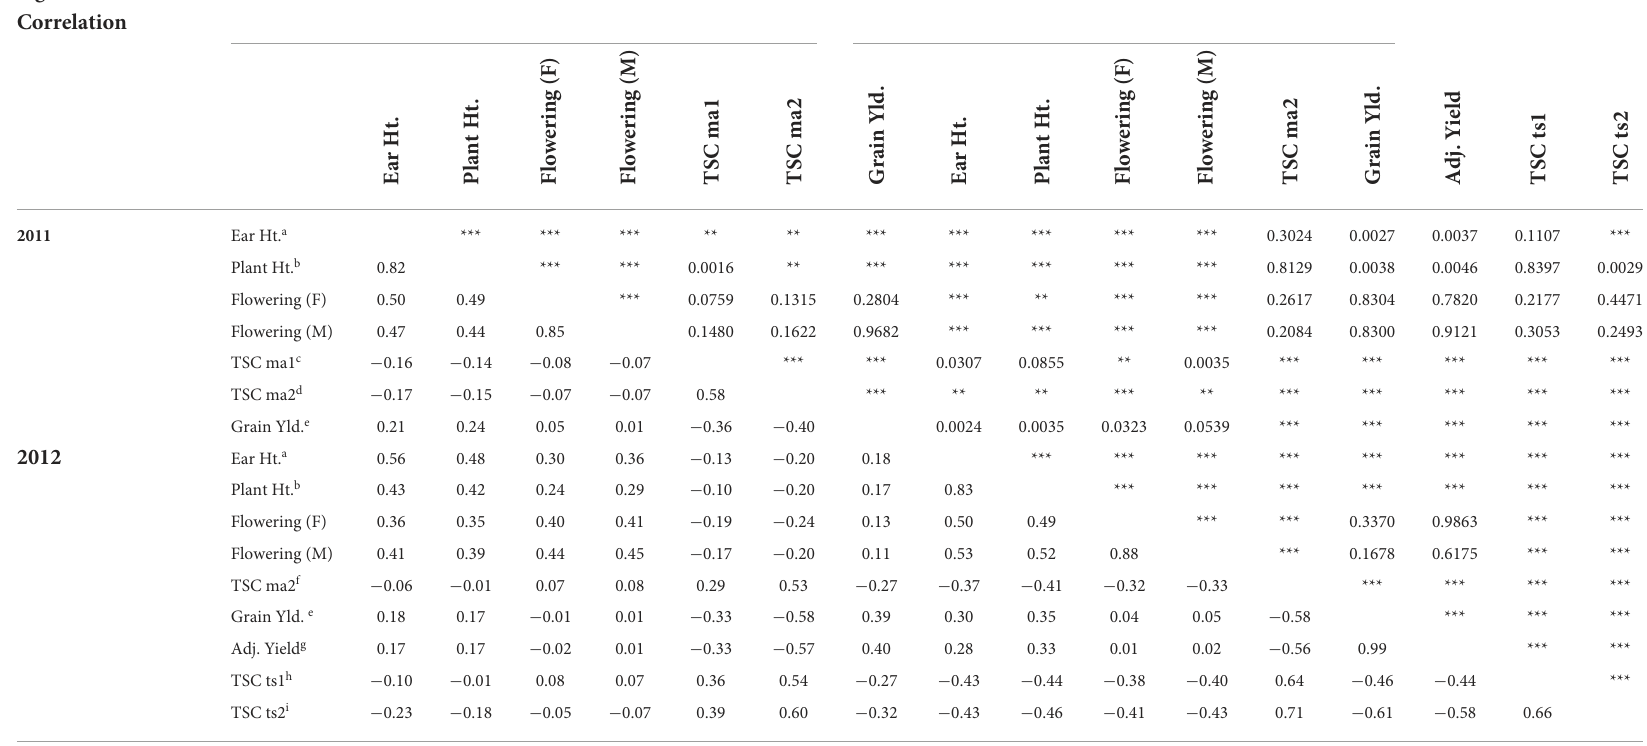
TABLE 3 Pearson correlation coefficients and the level of significance of TSC (tar spot complex)-related traits. Significance Level/